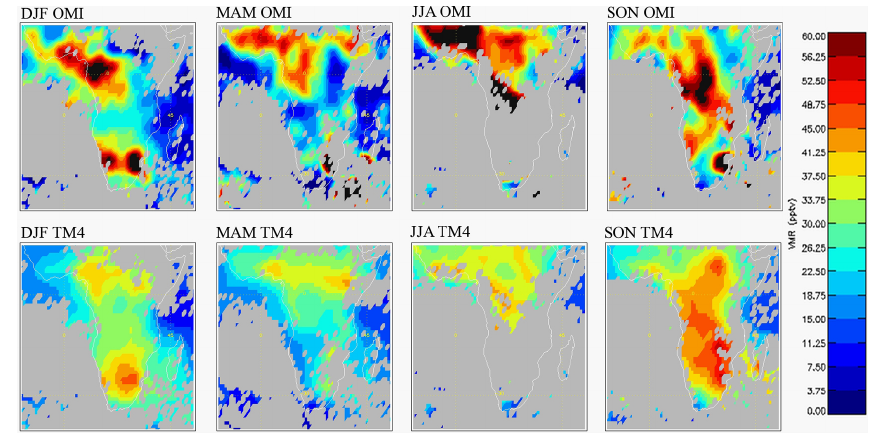
Figure 15. African sector at 280hPa: seasonal variability in OMI (top row) versus TM4 model (bottom row) average NO 2 VMR pseudopro- files for the year 2006.